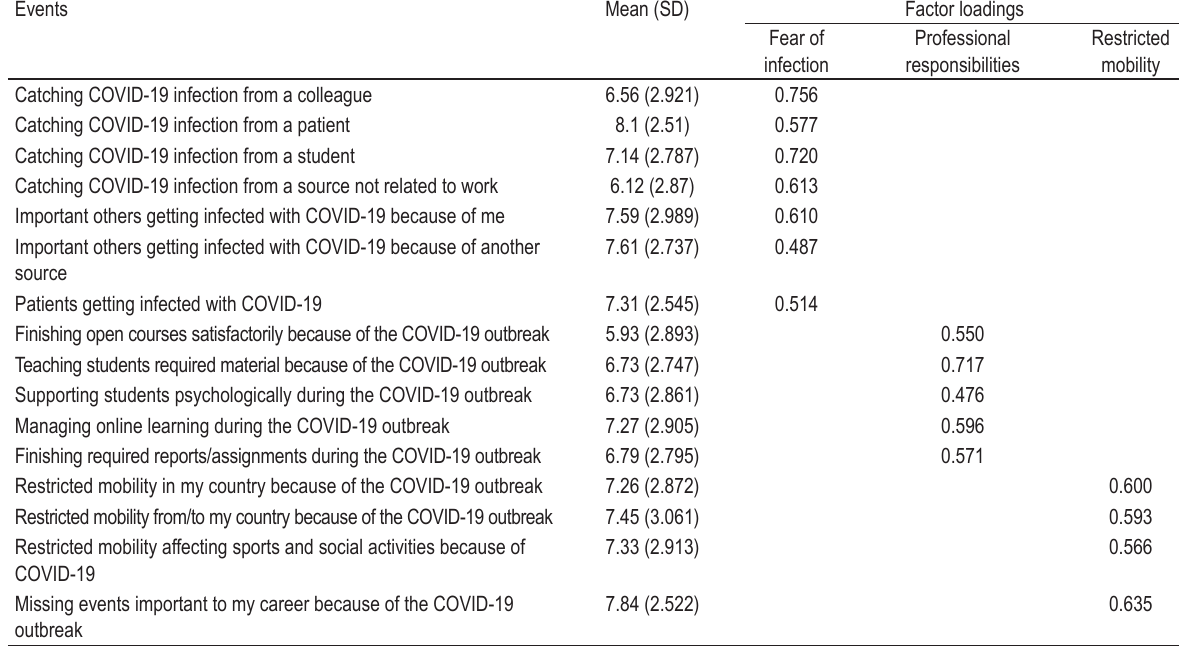
TABLE 2. Principal component analysis and factor loadings for major worries and attitudes related to COVID‑19